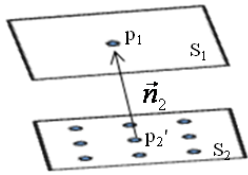
Figure 10. Distance between